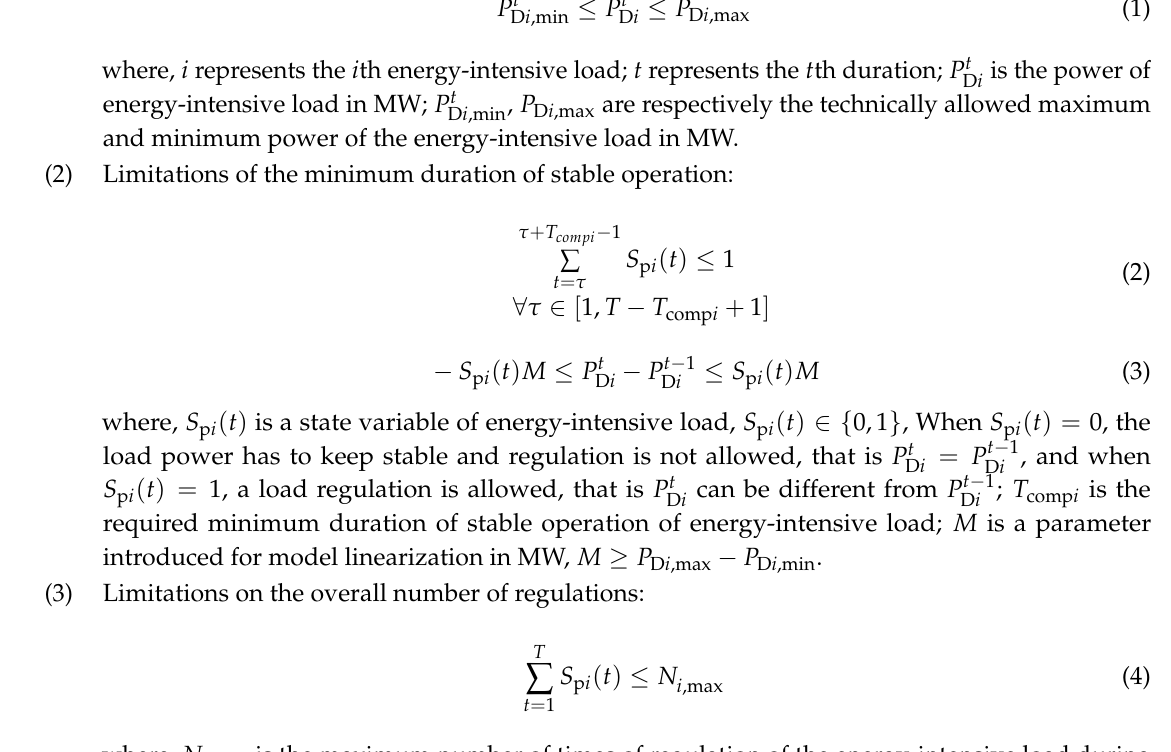
Figure 2. According to 2016 statistics, the maximum change of wind power in Hexi in 1 min, 5 min, 15 min are respectively 259 MW, 609 MW and 1457 MW, accounting for 2.5%, 5.9% and 14.1% of the installed capacity of wind power in Hexi [22].